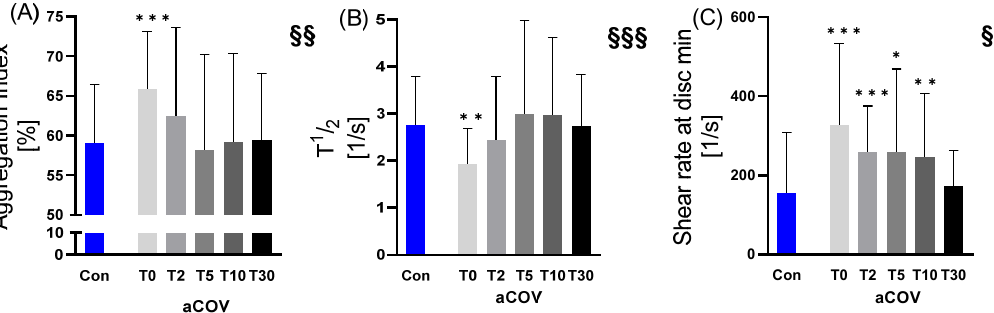
Figure 5. Aggregation parameters assessed for acute COVID-19 infected individuals (aCOV) at different time points at the intensive care unit (T0 hospital admission; T2 day 2; T5 day 5; T10 day 10; T30 day) compared to healthy controls (Con). While for ( A ) the Aggregation Index AI increased values were observed at hospital admission T0 in aCOV compared to Con, ( B ) decreased values in T 1 / 2 were seen at the same time point. ( C ) The shear stress at disc min—minimum change in back-scatter intensity found during the iteration procedure—was increased between time points T0–T10 compared to Con. A change of values over time was observed for AI, and T 1 / 2, the shear stress at disc min. * p ≤ 0.05; ** p ≤ 0.01; *** p ≤ 0.001 compared to Con; §§ p ≤ 0.01; §§§ p ≤ 0.001 changes over time in aCOV.